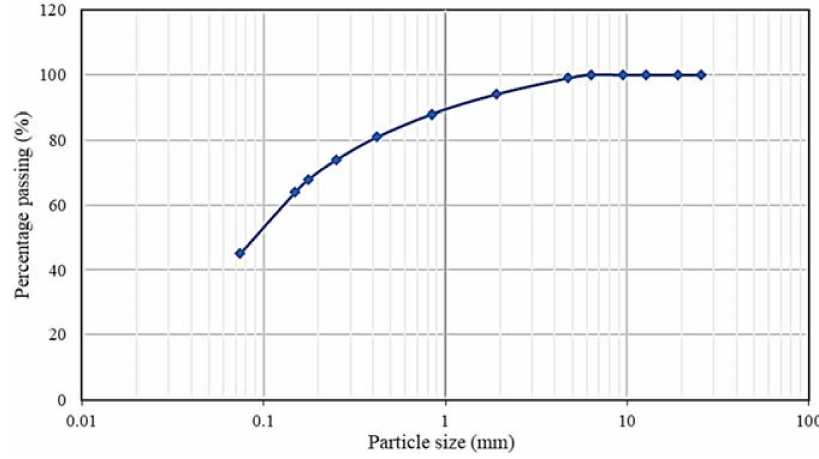
Figure 6. Soil’s granulometric classification curve.